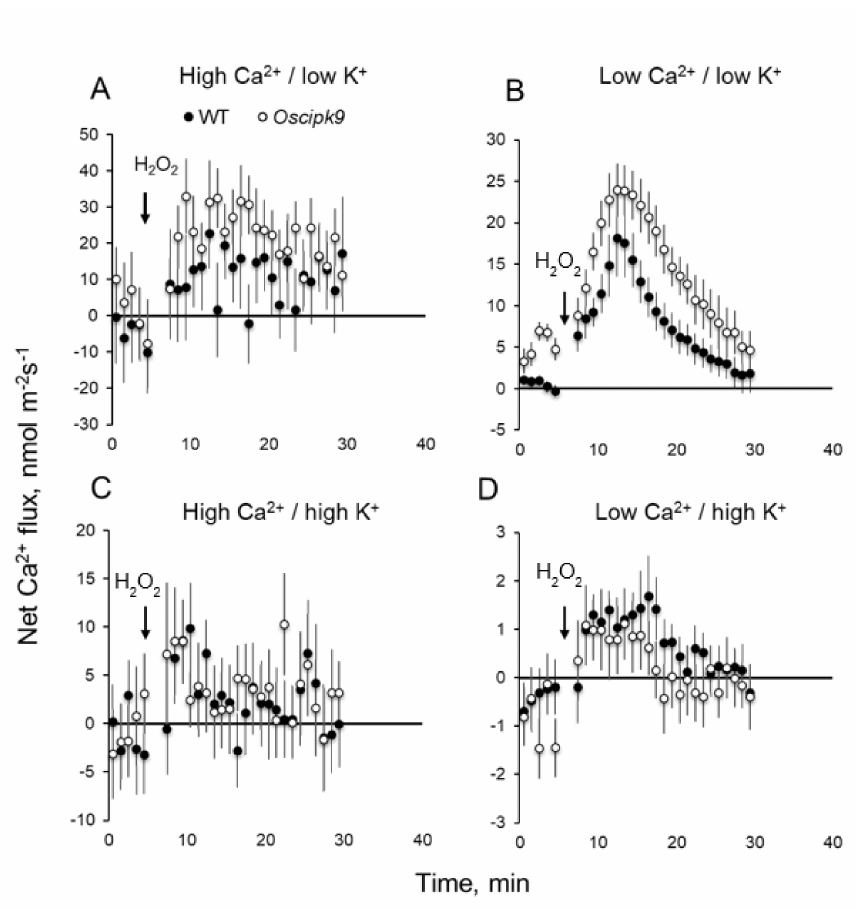
Figure 7. Effect of K + and Ca 2+ availability on kinetics of ROS-induced net Ca 2+ fluxes measured from epidermal mature root cells of Oscipk9 mutant and its WT. ROS stress was imposed by adding 5 mM H 2 O 2 to 5–6-day-old seedlings. ( A ) high Ca/low K (1.5 mM/0.1 mM) conditions; ( B ) low Ca/low K (0.1 mM/0.1 mM) conditions; ( C ) high Ca/high K (1.5 mM/10 mM) conditions; and ( D ) low Ca/high K (0.1 mM/10 mM) conditions. Open symbols— Oscipk9 ; closed